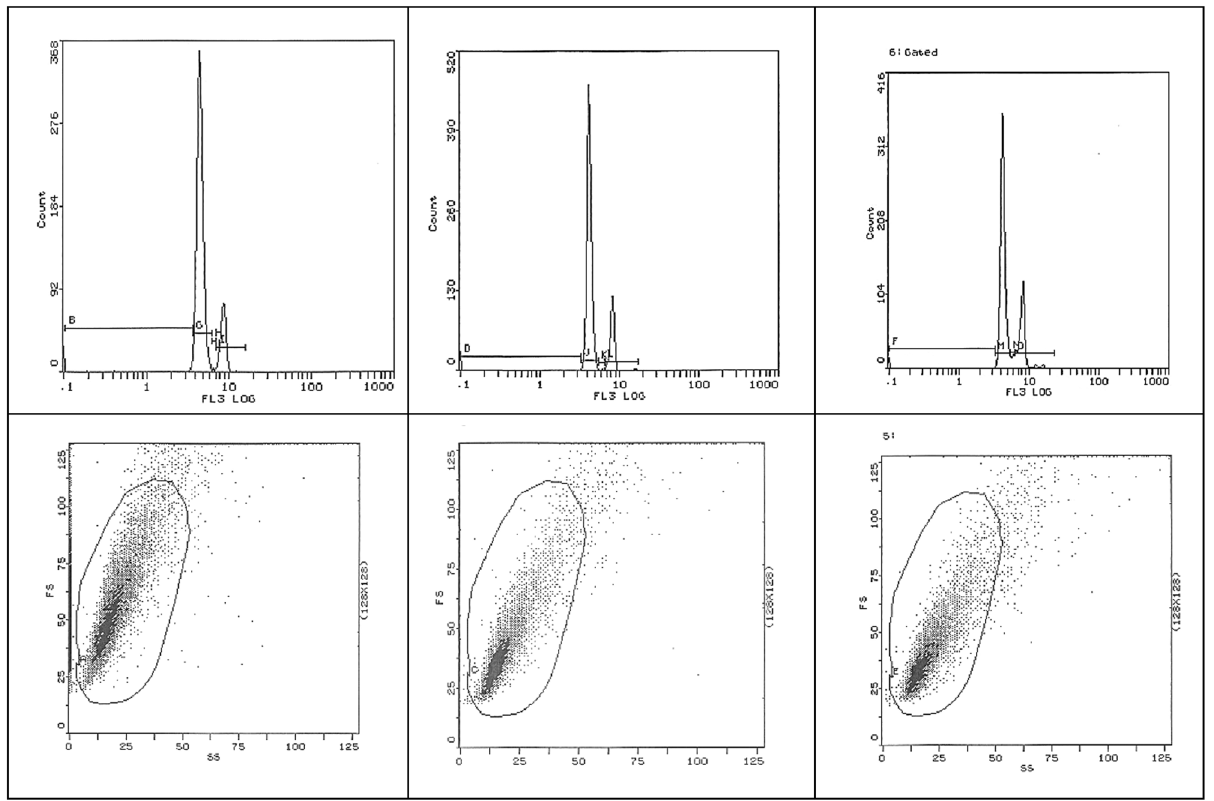
Figure 2: The di ff erent passage cells to make sure from their presence in the G0